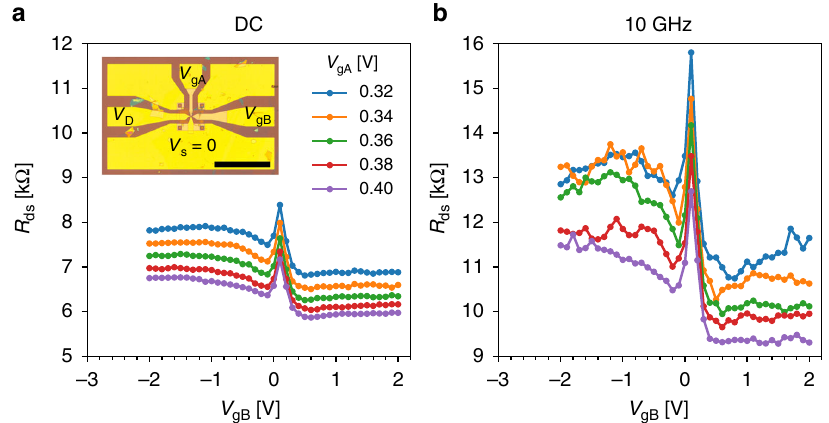
Fig. 4 High-frequency corner re fl ectors. a DC source-drain resistance R ds of sample CR-AuEG-17.ML (see Supplementary Note III) as a function of barrier gate voltage V gB for various access gate voltages. Inset: Optical image of the sample embedded in the coplanar wave guide. Scale bar is 200 µ m. b High frequency source-drain